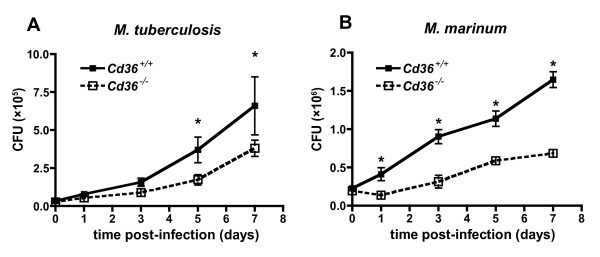
Co-cultivation of mycobacteria with Cd36-/- murine macrophages. In vitro, mycobacterial infection of thioglycolate-elicited peritoneal macrophages resulted in lower mycobacterial loads in cultures of Cd36-/- macrophages (white box, dashed line) compared with wild type controls (black box, solid line). A. Infection with M. tuberculosis (MOI = 10:1) produced a progressive rise in mycobacterial counts over 7 days, with significant difference (p < 0.0001) between groups. B. Similar results were seen after infection with the rapidly growing M. marinum (MOI = 1:1, p < 0.001). Data are shown as mean +/- 95% CI with 4 to 6 replicates at each time.